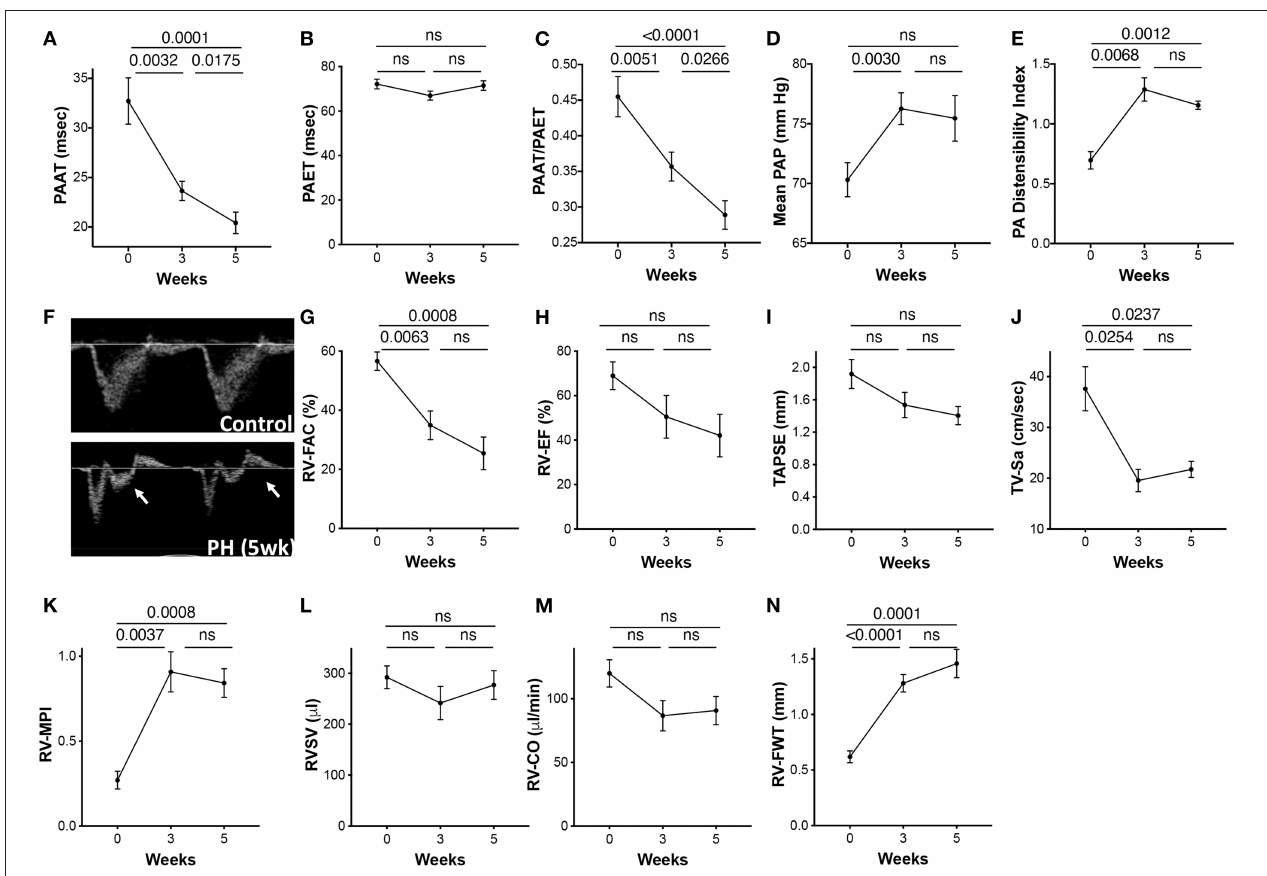
FIGURE 4 | Echocardiographic parameters of the pulmonary artery and the RV during progression of PAH. PAH was induced in rats over a 5-week period as described in the Methods. Echocardiographic images were acquired prior to induction of PH (0 day) and at 3 and 5 weeks post-induction. (A) Pulmonary artery acceleration time (PAAT), (B) pulmonary artery ejection time (PAET), (C) PAAT/PAET ratio, (D) calculated mean pulmonary artery pressure (mPAP), and (E) PA distensibility index, calculated as the ratio of the PA diameter (obtained from parasternal RV outflow tract view) to ascending aortic diameter from parasternal long axis flow at end diastole. (F) Pulse wave Doppler tracings showing the PA flow obtained from parasternal RV outflow view. Arrow shows the PA mid systolic notch. Each animal served as its own control at previous time points. A 2-dimensional echocardiographic examination of the RV was also performed from multiple acoustic views. (G) RV fractional area of change (RV-FAC) was measured from the transgastric midpapillary view, (H) RV-EF, (I) Tricuspid annular plane systolic excursion (TAPSE), (J) Tricuspid peak annular systolic velocity (TV-Sa), and (K) RV myocardial performance index (RV-MPI). (L) RVSV and (M) RV-CO were calculated from the parasternal long axis view. (N) RV free wall thickness (FWT) was measured from the apical four-chamber views. N = 10